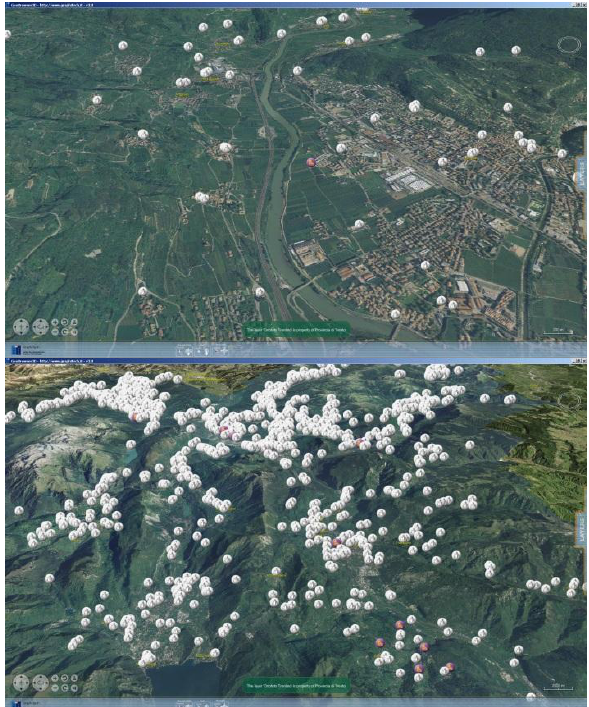
Figure 2: a screenshot showing the location of cultural relevance